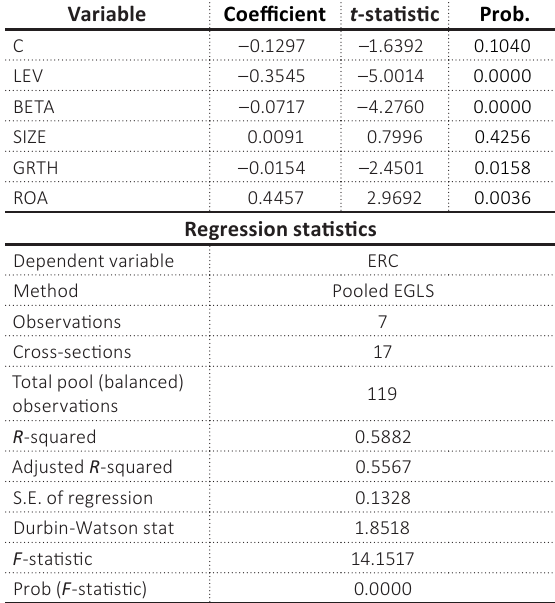
Table 3. The results of the regression analysis of the study model